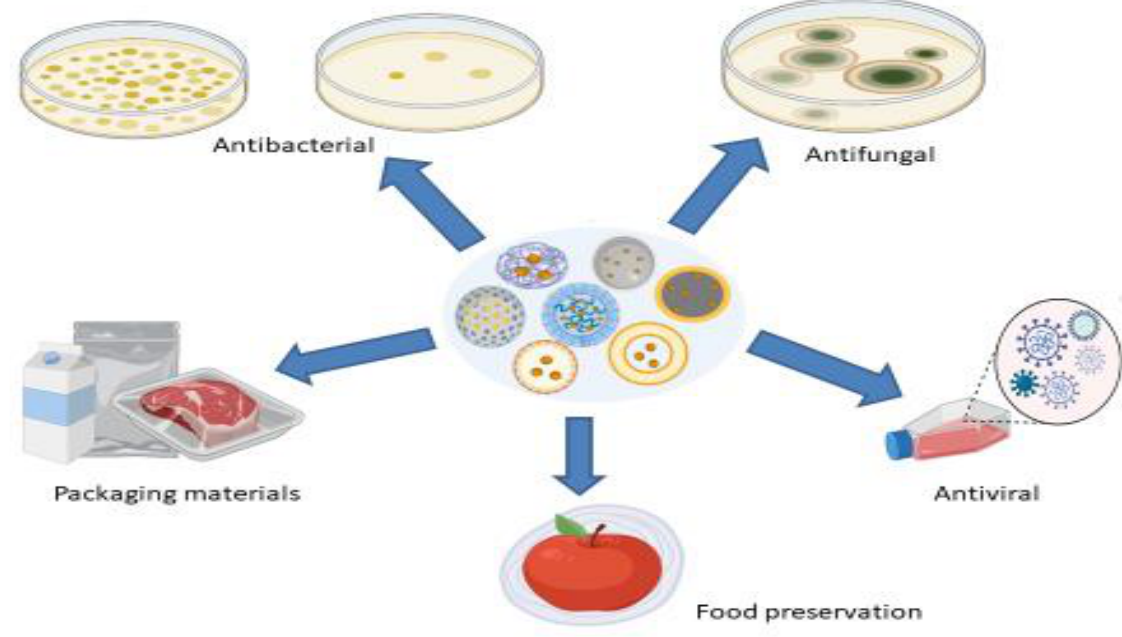
Figure 2. Application of nanoparticles.